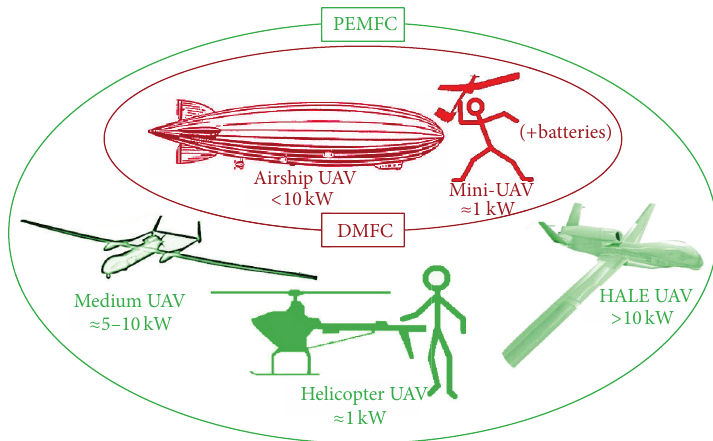
Figure 7: Possibilities of implementing fuel cells propulsion systems in